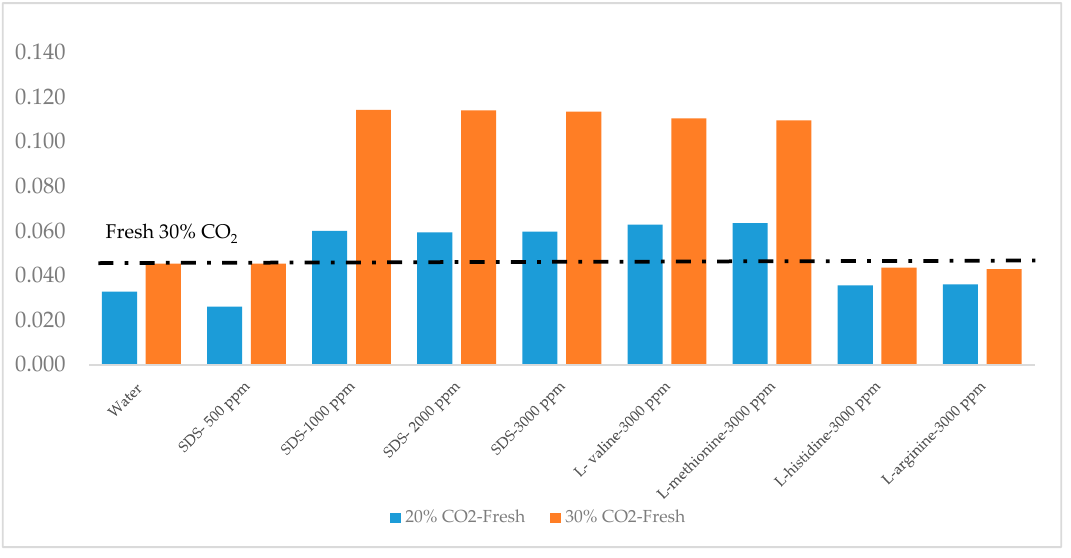
Figure 6. Gas uptake for fresh run (20% CO 2 and 30% CO 2 ). Gas uptake during fresh runs for 20 and 30 mole% CO 2 with SDS and amino acid.